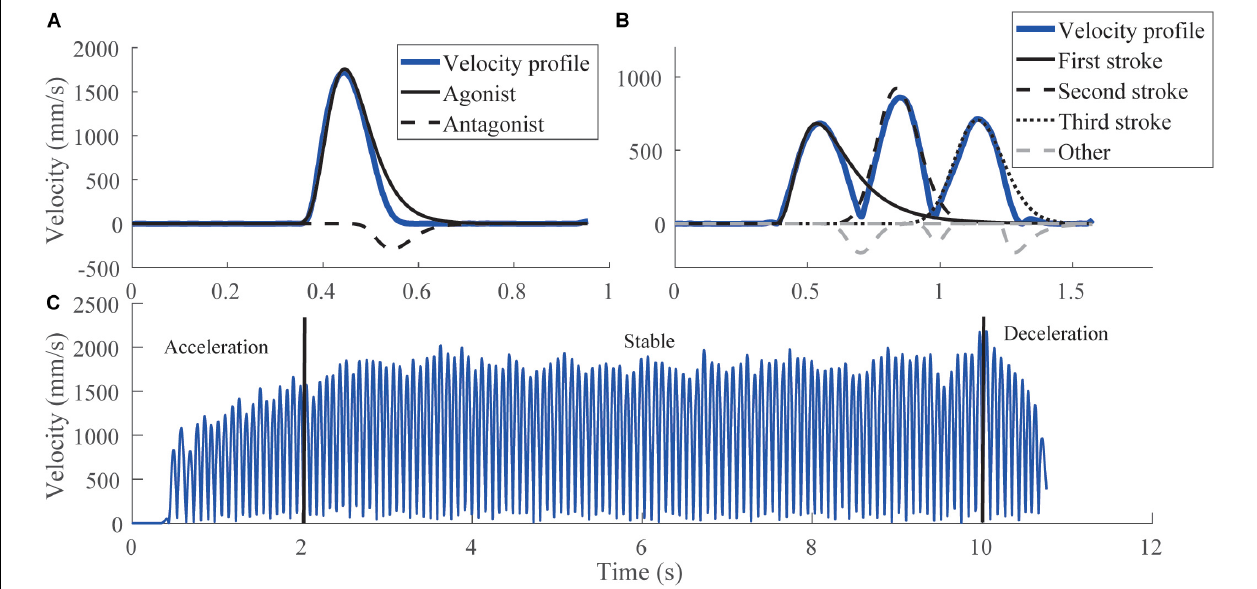
FIGURE 2 | Different categories of Lognormals for each test. (A) Original velocity profile (blue) of a simple stroke, with its decomposition into agonist and antagonist components. (B) Original velocity profile (blue) of a triangle with an extraction of the Lognormal corresponding to the first, second, or third stroke. Dashed gray lines correspond to other Lognormals used for reconstruction but not analyzed. (C) Original velocity profile (blue) of the oscillations, with the three-phase separation. The reconstruction of the velocity profile for oscillations is similar to the one of triangles, except that there are only agonist Lognormals, as the movement is fluent and stops only after the 10